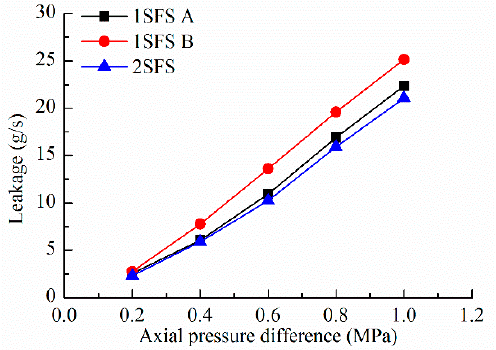
Figure 12. Comparison of leakage between 2SFS and 1SFSs.